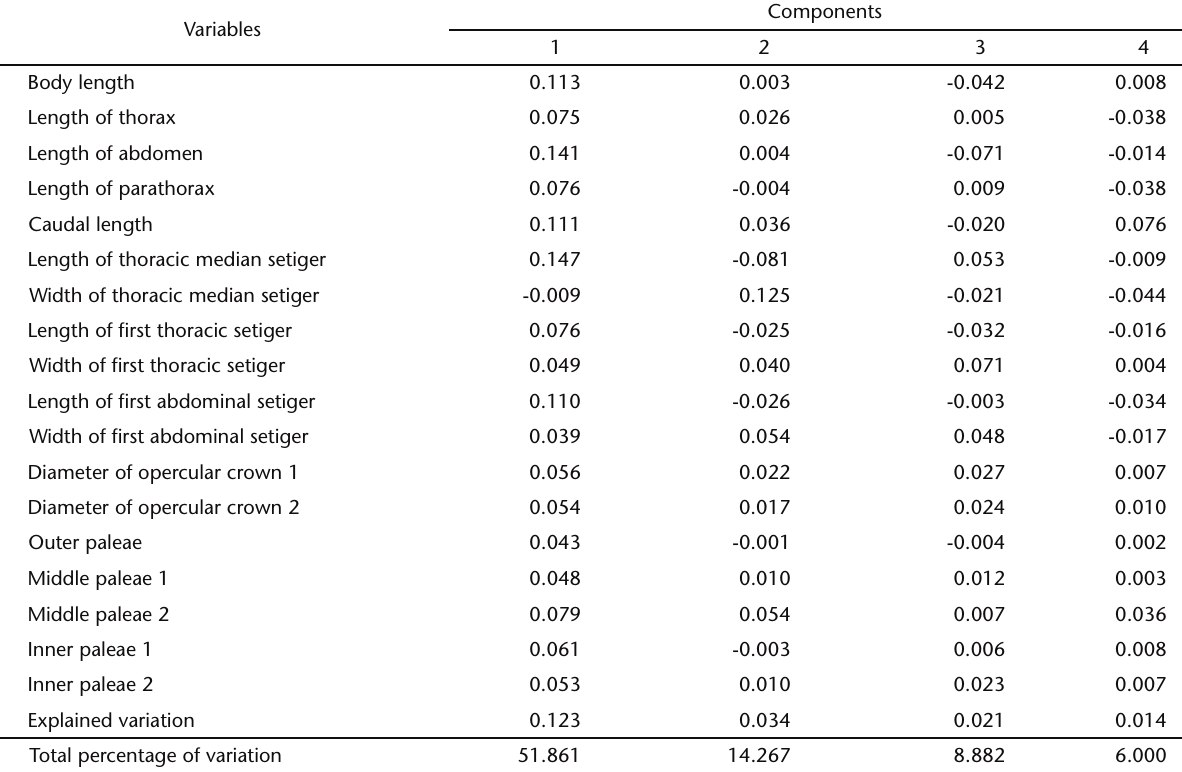
Table III. Results from the first four components of the Principal Component Analysis (PCA), showing the scores of the measured variables for each of the component and their respective accumulated variance.